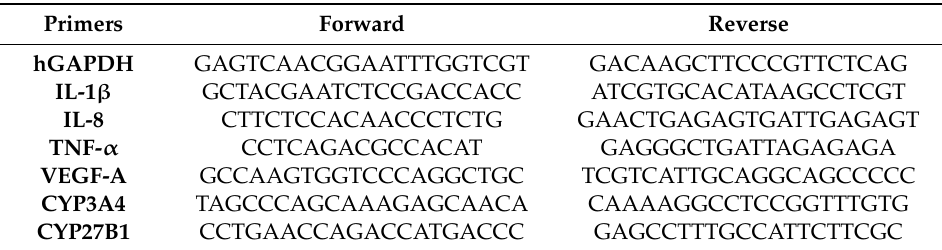
Table 2. Primers sequences.